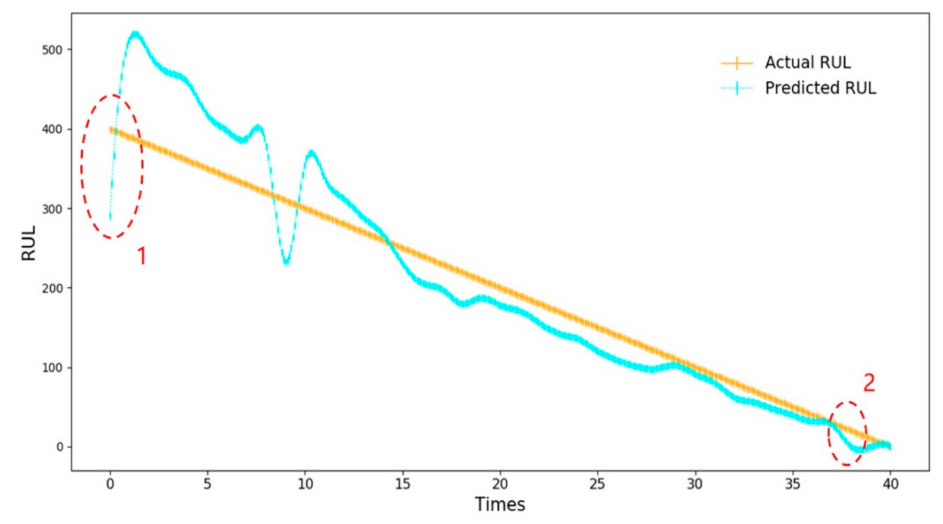
Figure 7. Residual lifetime prognosis of